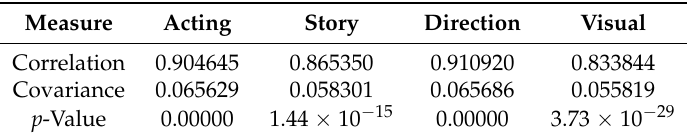
Table 3. Statistical analysis of the